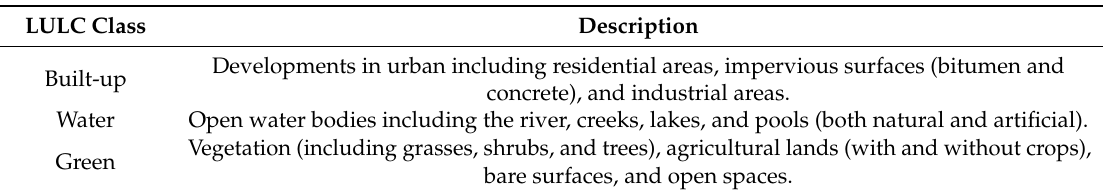
Table 3. Description of the LULC